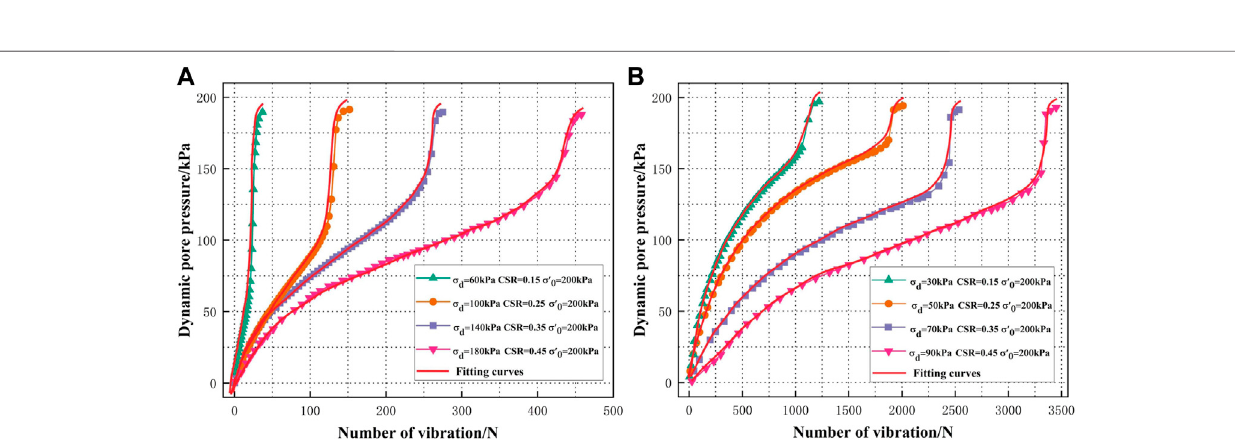
Frontiers in Earth Science |